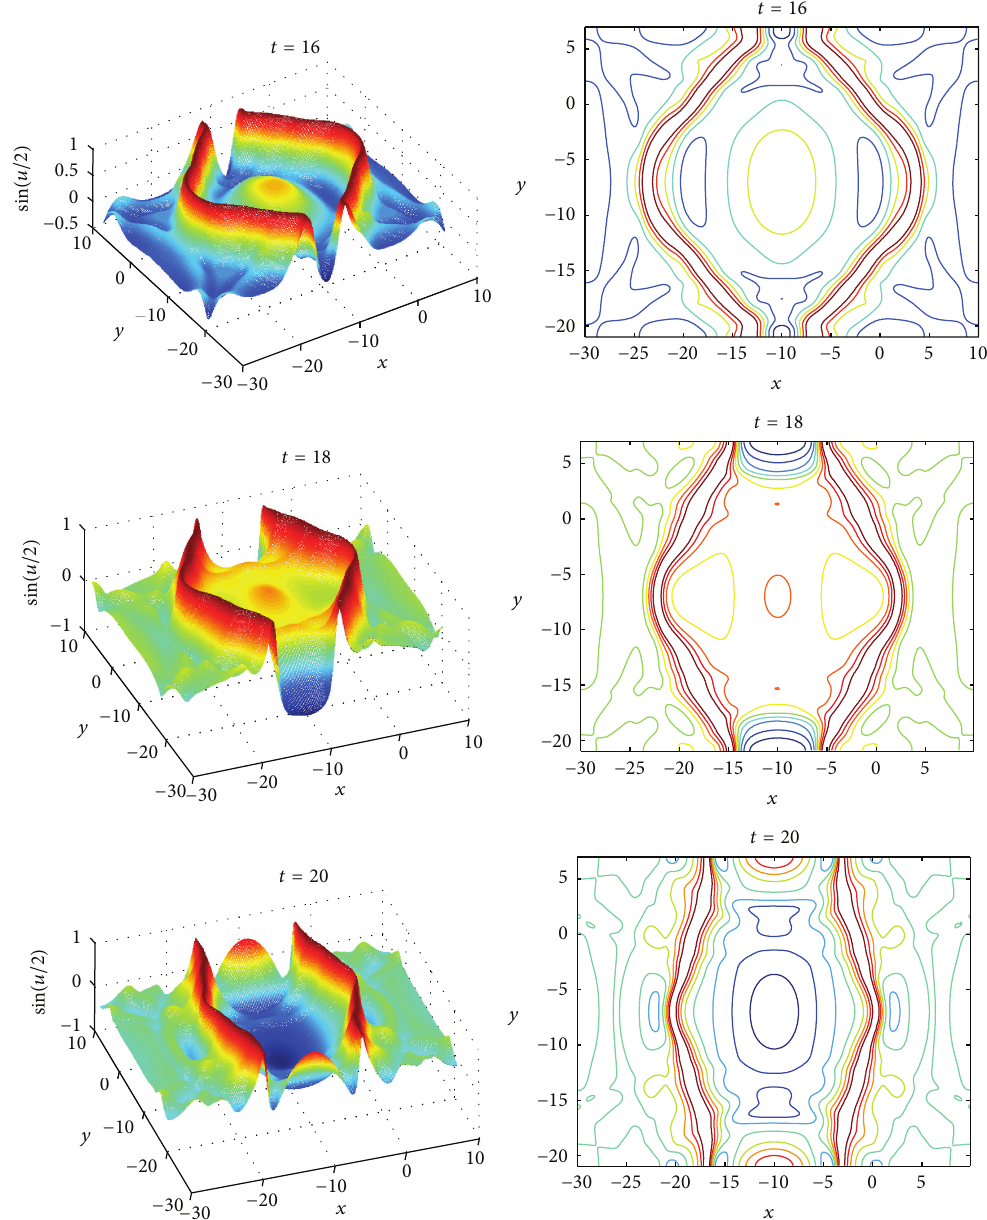
Figure 7: Collision of two circular solitons, at 𝑡 = 0, 2, 4, 6,8, 10, 12, 14, 16, 18, 20 with 𝜌 = 0